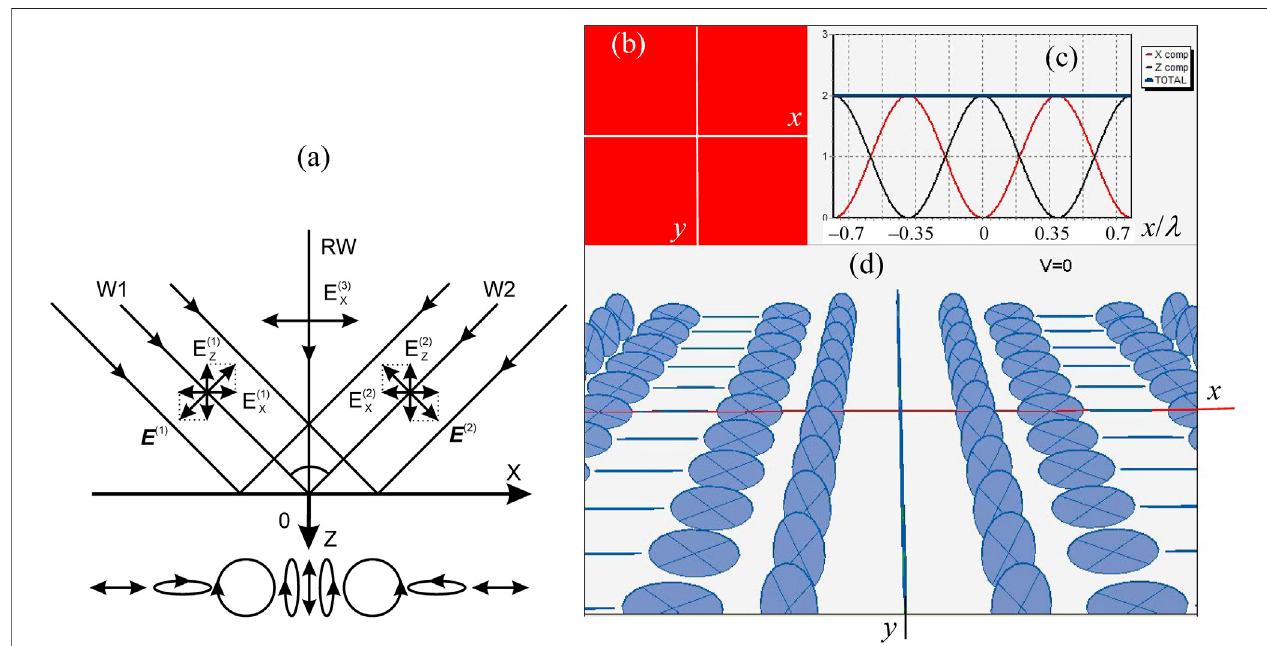
FIGURE 3 | Polarization properties of the fi eld formed by two orthogonal plane waves W1 and W2 with equal amplitudes, linearly polarized in the ( x , z )-plane. (A) Geometric con fi guration of the waves; (B) intensity distribution in the ( x , y )-plane (plane of observation); (C) partial intensities of the orthogonally polarized components and the resulting fi eld (corresponding visibility of the interference pattern V = 0); (D) schematic view of the polarization ellipses in different points of the ( x , y